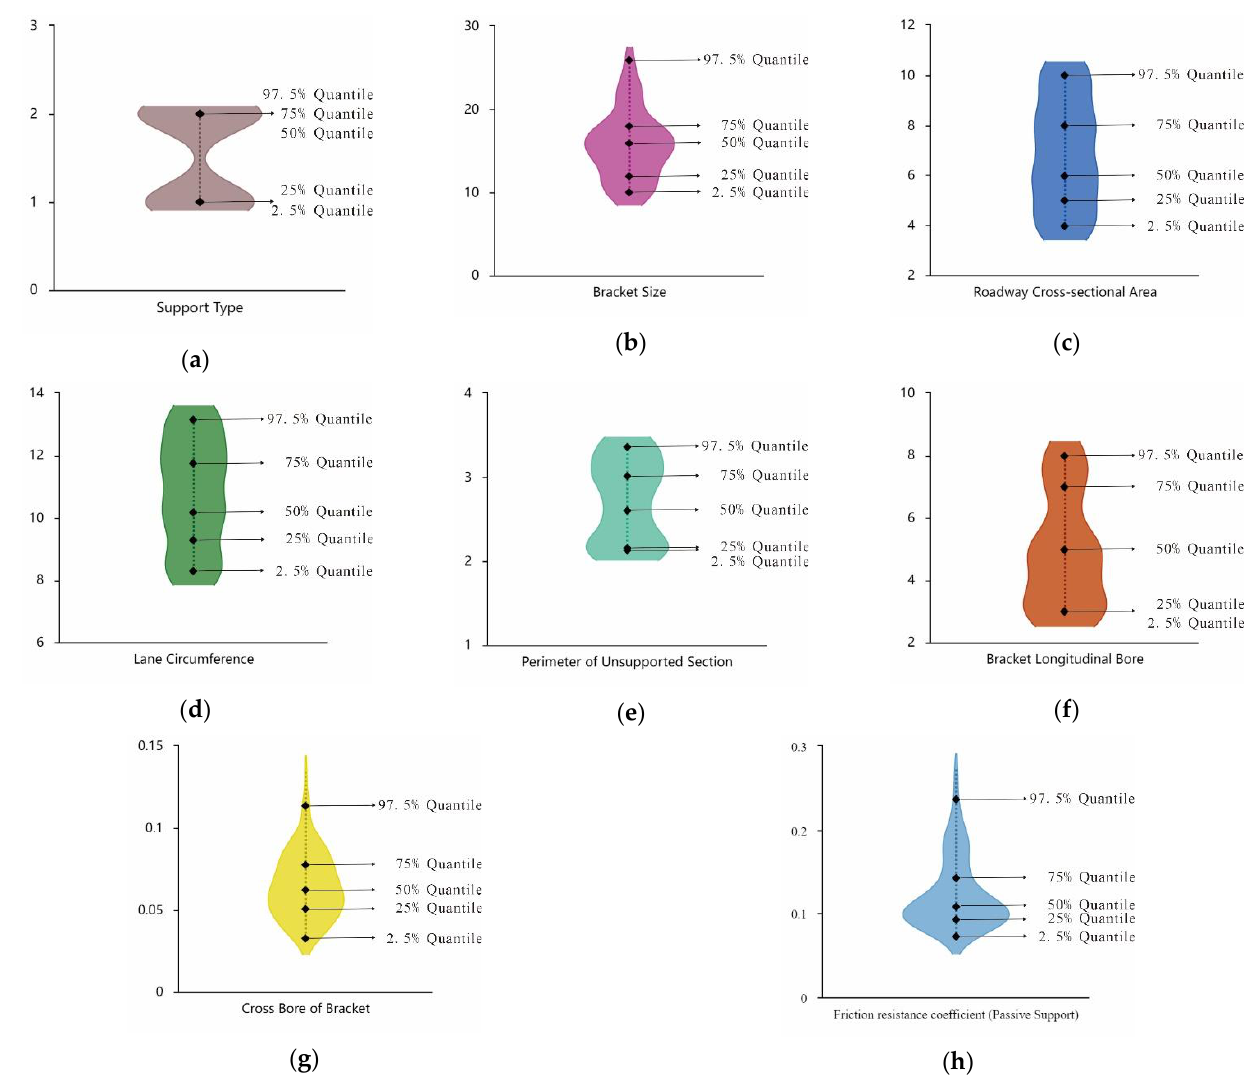
Figure 6. Violin plots showing the distribution of the passive support dataset. ( a ) Violin plot of the support-type data; ( b ) violin plot of the bracket size data; ( c ) violin plot of the roadway cross-sectional area data; ( d ) violin plot of the lane circumference data; ( e ) violin plot of the perimeter of the unsupported section data; ( f ) violin plot of the bracket longitudinal bore data; ( g ) violin plot of the cross-bore of bracket data; ( h ) violin plot of the friction resistance coefficient (passive support) data. Table 4. Input parameters of the RF